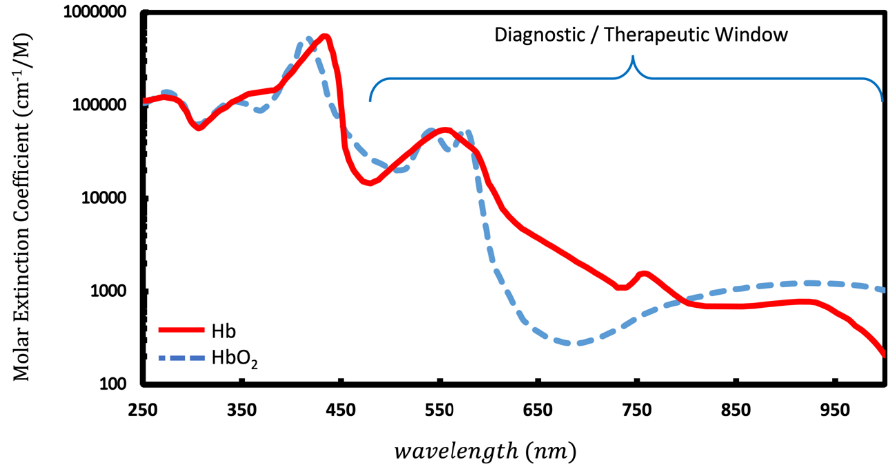
Figure 2. The light absorption of the deoxyhemoglobin (Hb) and oxyhemoglobin (HbO 2 ) of biological tissue (re-drawn from the data taken from Ref. [37]). In the diagnostic window, the absorption level between Hb and HbO 2 is notable, and water absorption is at its minimum.